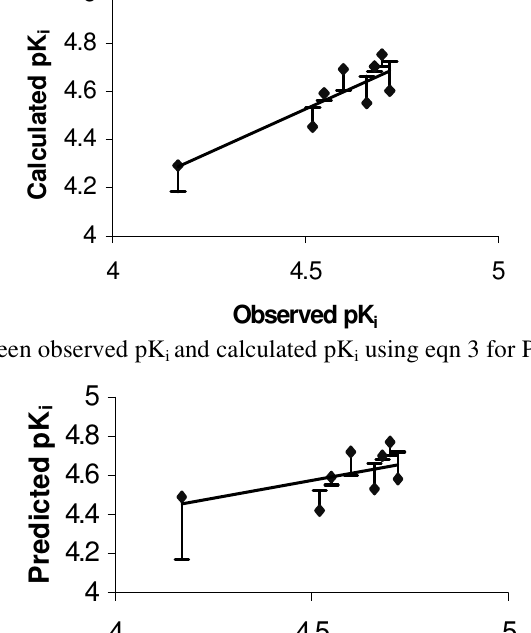
and predicted pK i